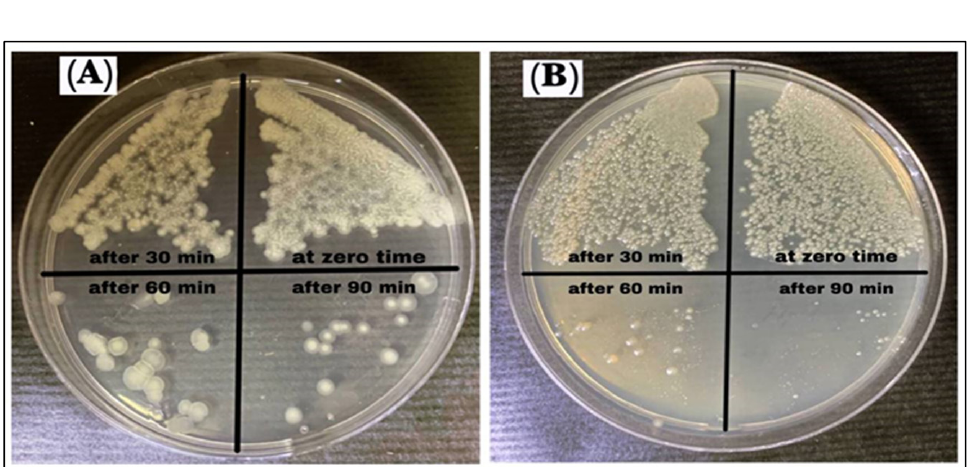
Table 6. Growth curve assays of AgNPs against B. cereus and P. mirabilis . Bacteria